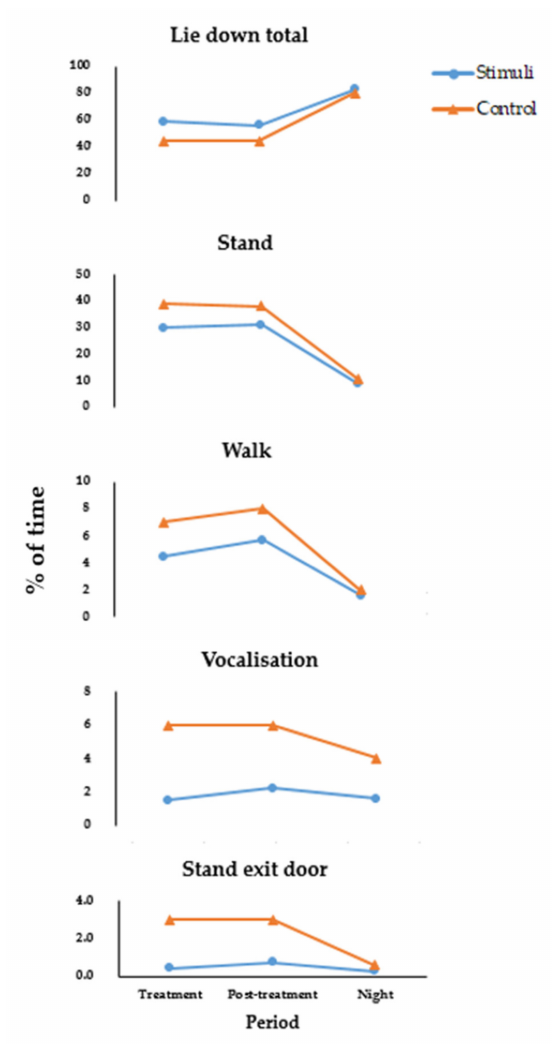
Figure 3. Proportion of time spent by dogs ( n = 60) in the Control and amalgamated stimuli treatments (Music, Lavender and DAP), during the Treatment, Post-treatment and Night periods, demonstrating the elimination of these treatment e ff ects except vocalization by the night